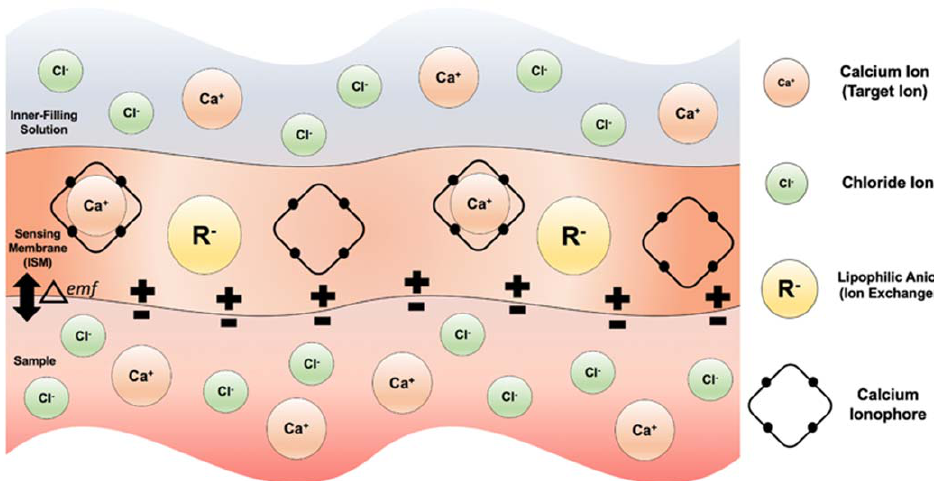
Figure 2. Schematic representation of the Ion-Selective Membrane for a 3D printed LC-Ca 2 +